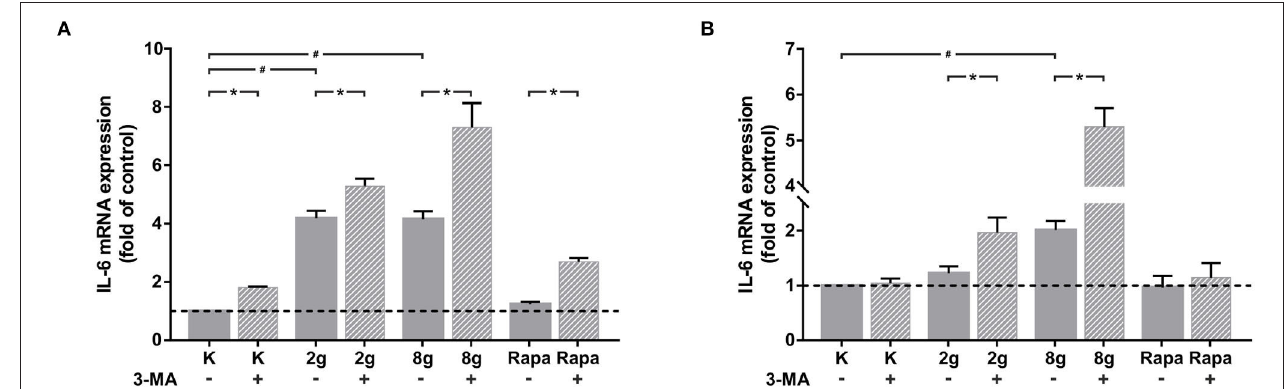
FIGURE 4 | (A) Effects of mechanical stimulation (2 or 8 g/cm 2 ) or Rapamycin (Rapa; 50 nM) with or without autophagy inhibitor 3-MA on il-6 gene expression at 16 h as determined by rtPCR. Untreated cells served as control. Mean ± SEM ( n = 6); # significant ( p < 0.05) difference between groups as determined by Dunnett’s T -test. ∗ significant ( p < 0.05) difference between two groups (uninhibited and inhibited) as determined by the Mann-Whitney-Test. (B) Effects of mechanical stimulation (2 or 8 g/cm 2 ) or Rapamycin (Rapa; 50 nM) with or without autophagy inhibitor 3-MA on il-6 gene expression at 24 h as determined by rtPCR. Untreated cells served as control. Mean ± SEM ( n = 6); # significant ( p < 0.05) difference between groups as determined by Dunnett’s T -test. ∗ significant ( p < 0.05) difference between two groups (uninhibited and inhibited) as determined by the